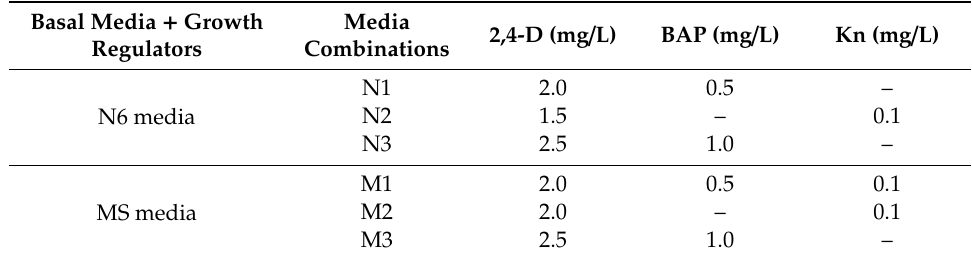
Table 3. Two di ff erent basal media MS and N6 with three di ff erent combinations and concentrations of growth regulators for callus induction.